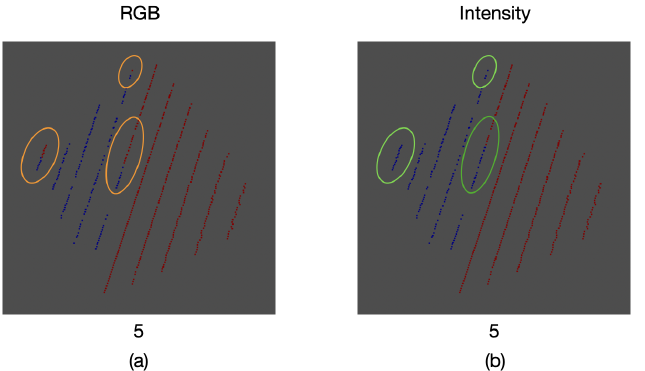
Figure 21. Comparison between the intensity and color information thresholding stages. Some areas with wrongly mapped points are highlighted.